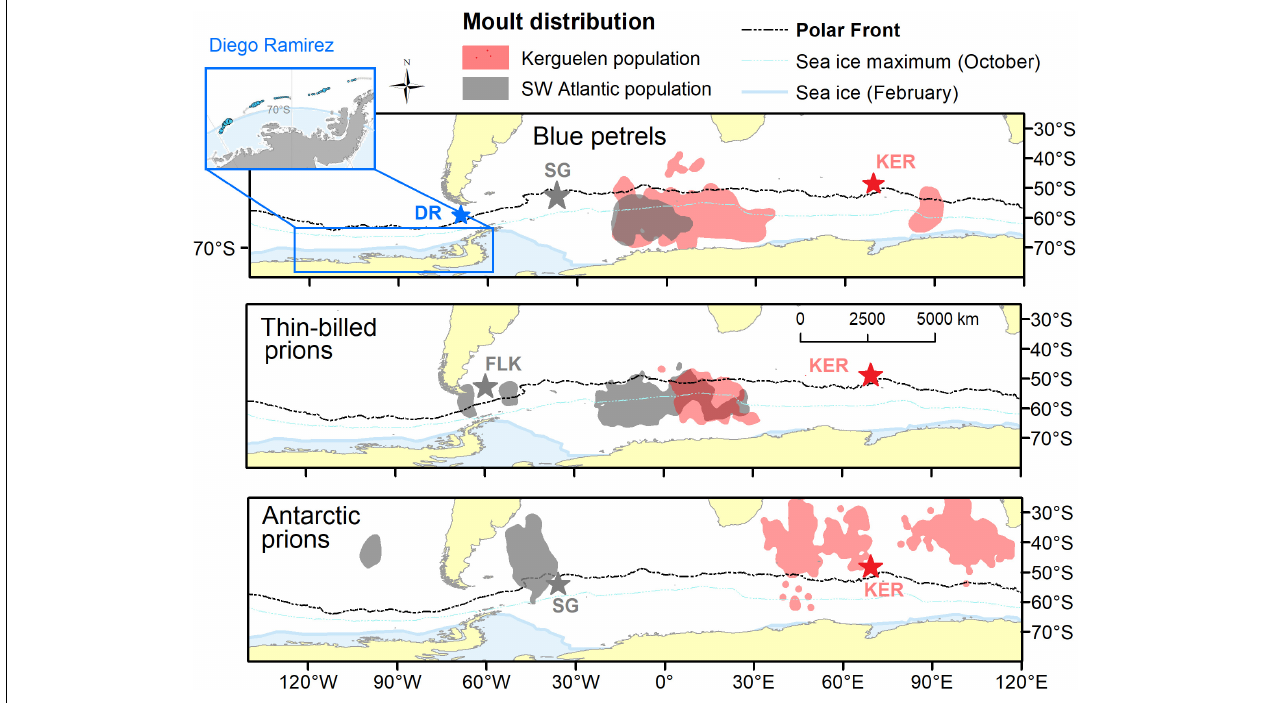
FIGURE 1 | Distribution of Blue Petrels, Thin-billed Prions, and Antarctic Prions during primary moult (i.e., the core moult area). Colony sites: Diego Ramirez (DR), South Georgia (SG), Falkland Islands (Malvinas) (FLK), and Kerguelen (KER). Blue Petrels moulting in February between 71 ◦ S, 119 ◦ W and 67 ◦ S, 78 ◦ W are most likely birds from the large Diego Ramirez colony (Ryan et al., 2020). Moult takes place around the time of the minimum sea-ice extent (February–April) in Blue Petrels and Thin-billed Prions, and during August–October in Antarctic